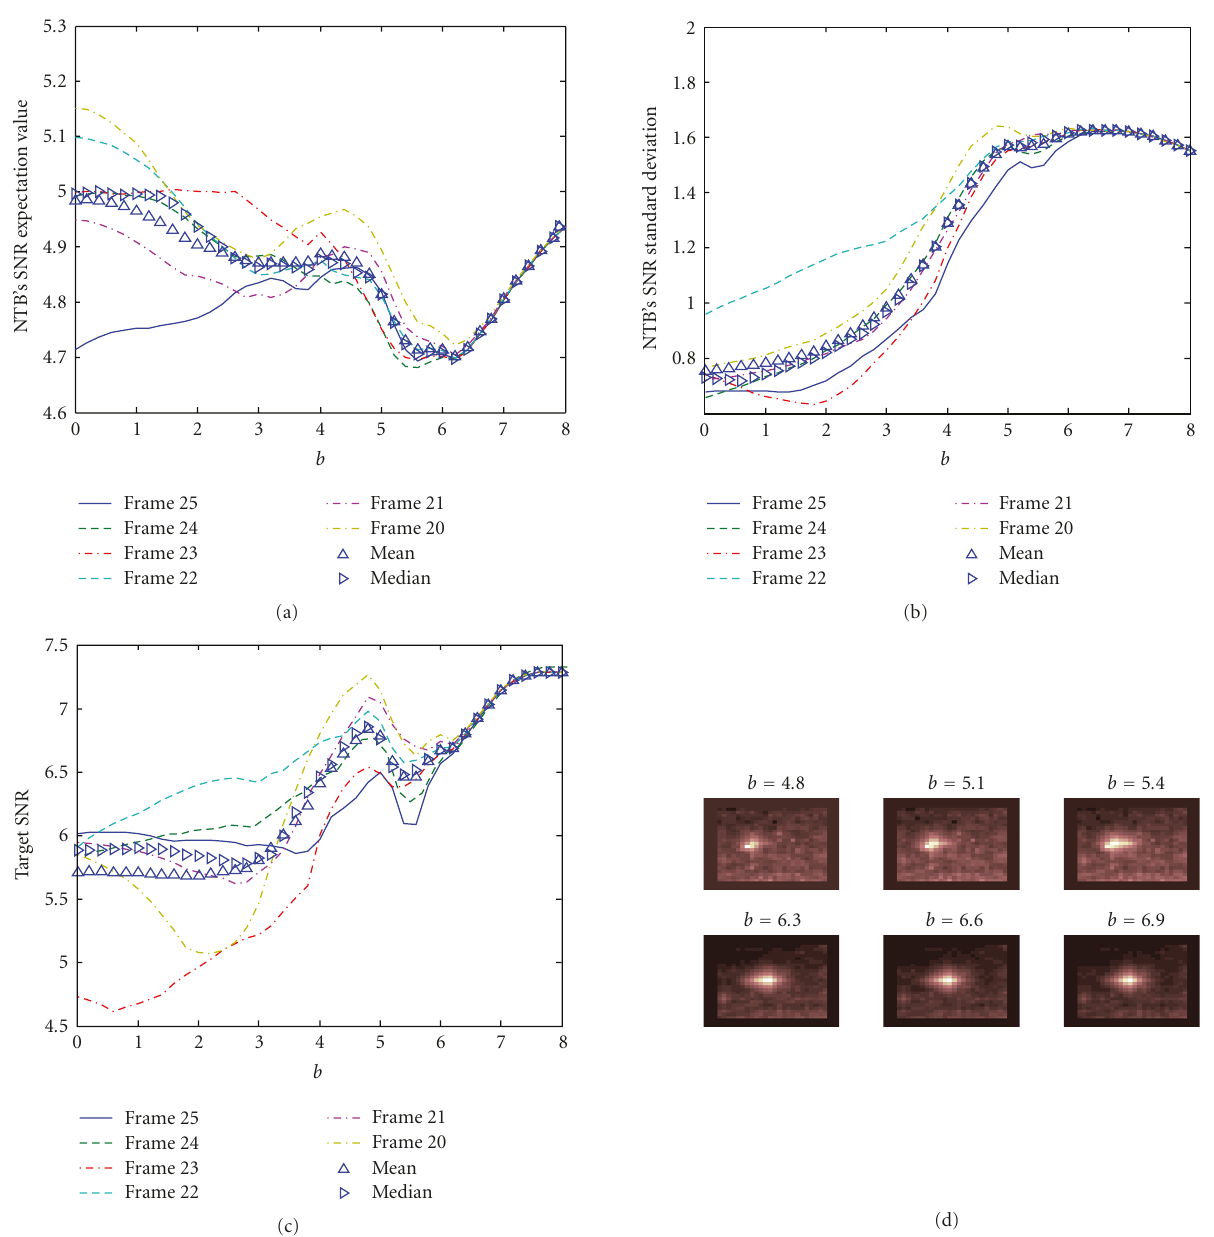
Figure 10: NA23A sequence preliminary results; g = 0, Max Numbers = 5. (a) Standard deviation of NTB’s SNR, (b) expectation value of NTB’s SNR, (c) TB’s SNR, and (d) last-processed frame (25th) for various values of b